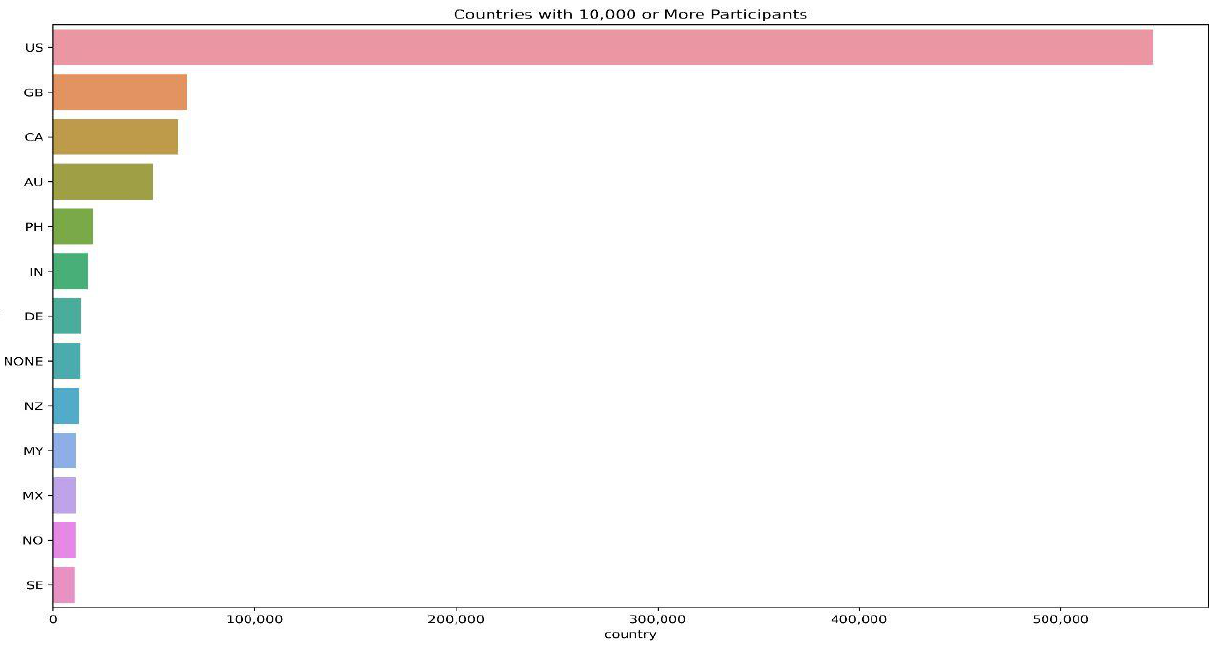
6 of 18 Figure 2. Architecture of the proposed methodology.